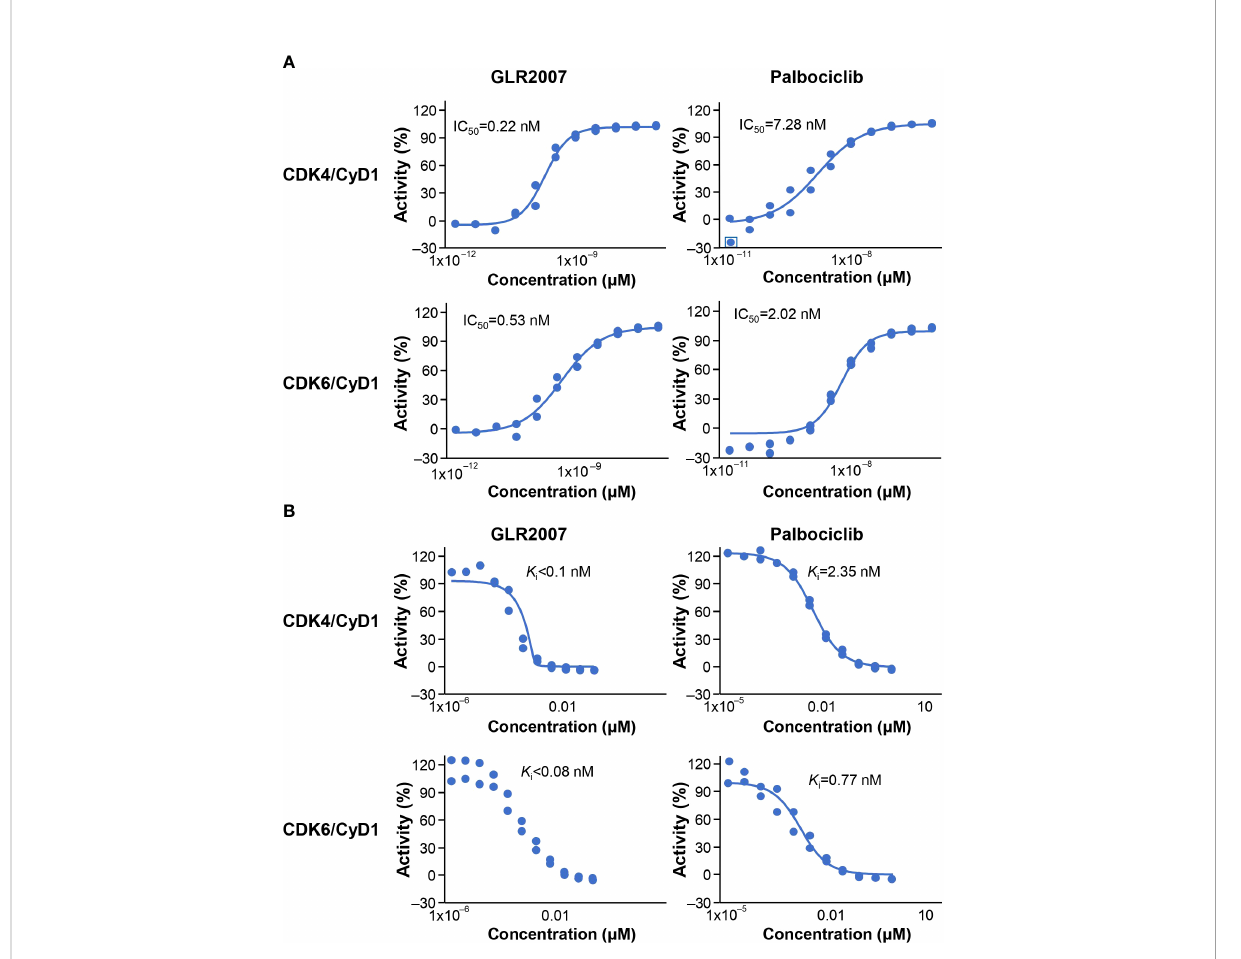
FIGURE 1 Inhibition of CDK4/CycD1 and CDK6/CyD1 enzymatic activity by GLR2007 and palbociclib. Results were calculated across 11 concentrations, measured in duplicates, within the range of 0.0017 – 100 nM GLR2007 and 0.0169 – 1000 nM palbociclib, and inhibition of kinase activity expressed as (A) IC 50 and (B) K i . Mean inhibition values are shown within each plot. CDK, cyclin-dependent kinase; CyD1, cyclin D1;